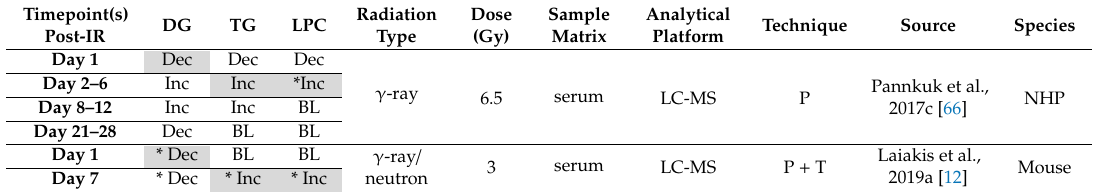
Table 2 abbreviations and key: Agreement in lipid changes within a similar timepoint between studies have been shaded. * p ≤ 0.05 in at least one lipid subclass. Trend : Inc (increase), Dec (decrease), or V (variable).